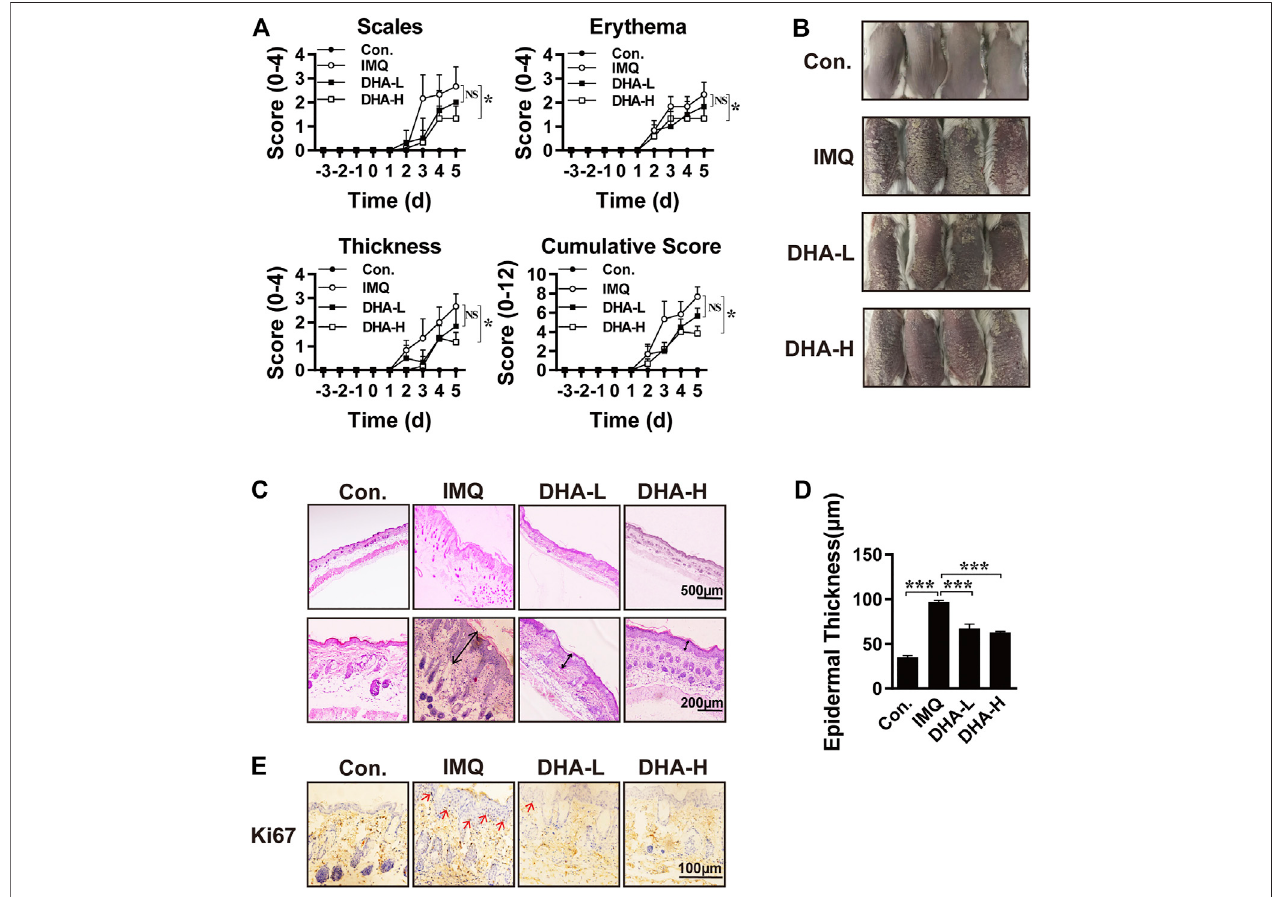
FIGURE 2 | DHA treatment attenuated psoriasis severity. (A) These selected mice were classi fi ed into four groups as described above, clinical indicators scales, erythema, and skin thickness for PASI clinical evaluation to assess the severity of psoriasis and the ef fi cacy of DHA (* p < 0.05, NS. Not signi fi cant). (B) Representative macroscopicskinlesion symptoms ineach group. (C) H&Estainingwasperformedtoobservethepathologicalchangesinmice ’ sskin.Originalmagni fi cations, top × 40; bottom × 200. (D) Epidermal thickness was measured after DHA treatment in the psoriasis model (*** p < 0.001). (E) Keratinocyte proliferation was analyzed by detectingtheexpressionofKi67.Originalmagni fi cations, × 400.StatisticalanalysiswascarriedoutusingOne-wayANOVAanalysisofvariancefollowedbyDunnett ’